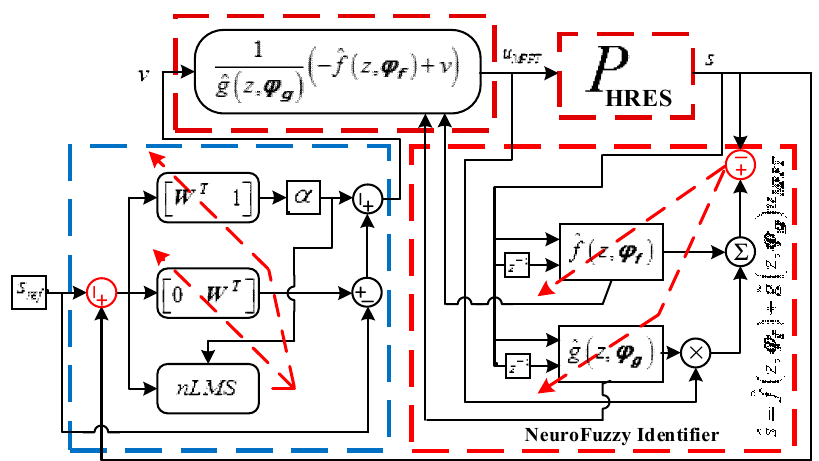
Figure 2. Adaptive Feedback linearization based NeuroFuzzy photovoltaic (PV) maximum power point tracking (MPPT). HRES: hybrid renewable energy system.